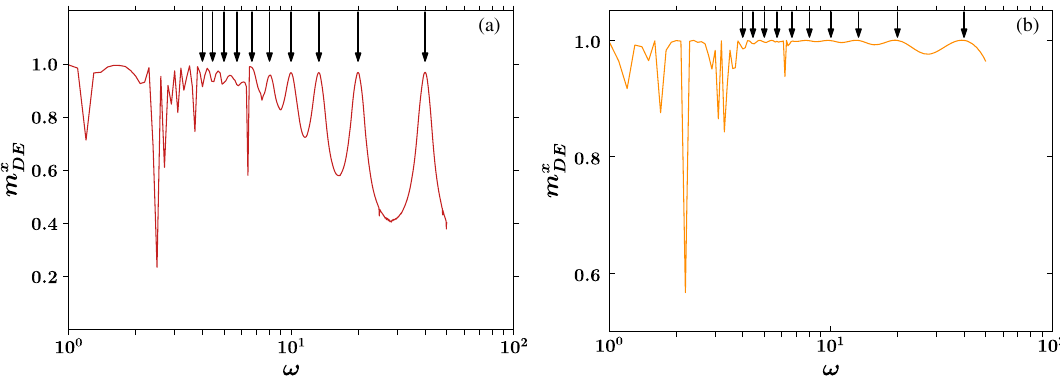
FIG. 6. Infinite-time limit of the magnetization, m x , versus driving frequency ω for Hamiltonians of the form in Eq. (6) but with DE x ð 3 Spin Þ H x H x ð LR Þ different types of H x 0 , namely, three-spin interactions [(a) H x 0 ¼ H 0 ¼ 0 , Eq. (45)] and long-range interactions [(b) 0 , Eq. (46)]. The strong freezing of m x near the freezing points ( ω ¼ h x D =k ) is observed in agreement with the prediction of the DE Magnus expansion up to the two leading orders in both cases. Interestingly, small corrections due to the higher-order terms are also observed, namely, small deviations of the peak heights from unity for the three-spin case, and tiny shifts of the peak from the freezing condition for the long-range case. Apart from these corrections, the higher-order terms do not appear to change any of the key aspects of the phenomenon (strong emergent conservation of m x at all times and consequent lack of unbounded heating). Here, the parameters are J xxx ¼ 0 . 5 ; J ¼ 1 ; κ ¼ 0 . 7 π = 3 ; h x 0 ¼ e= 10 ; h z ¼ 1 . 2 ; h x D ¼ 40 ; L ¼ 20